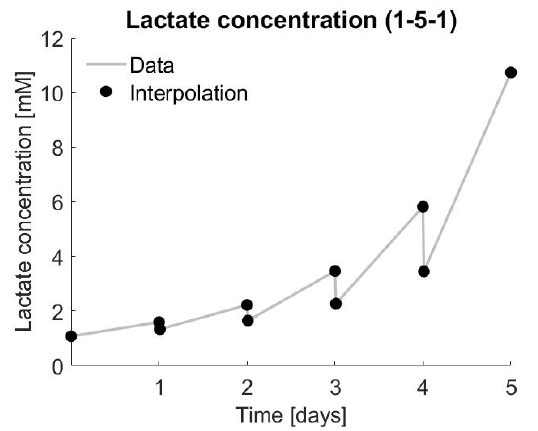
Figure 4. Lactate concentration over time (days) for the results of donor 1, condition 5 and triplicate 1. Table 2. Total amount of cells harvested after the cell culture expansion, which is averaged over the triplicates for each donor and condition (100,000 cells).